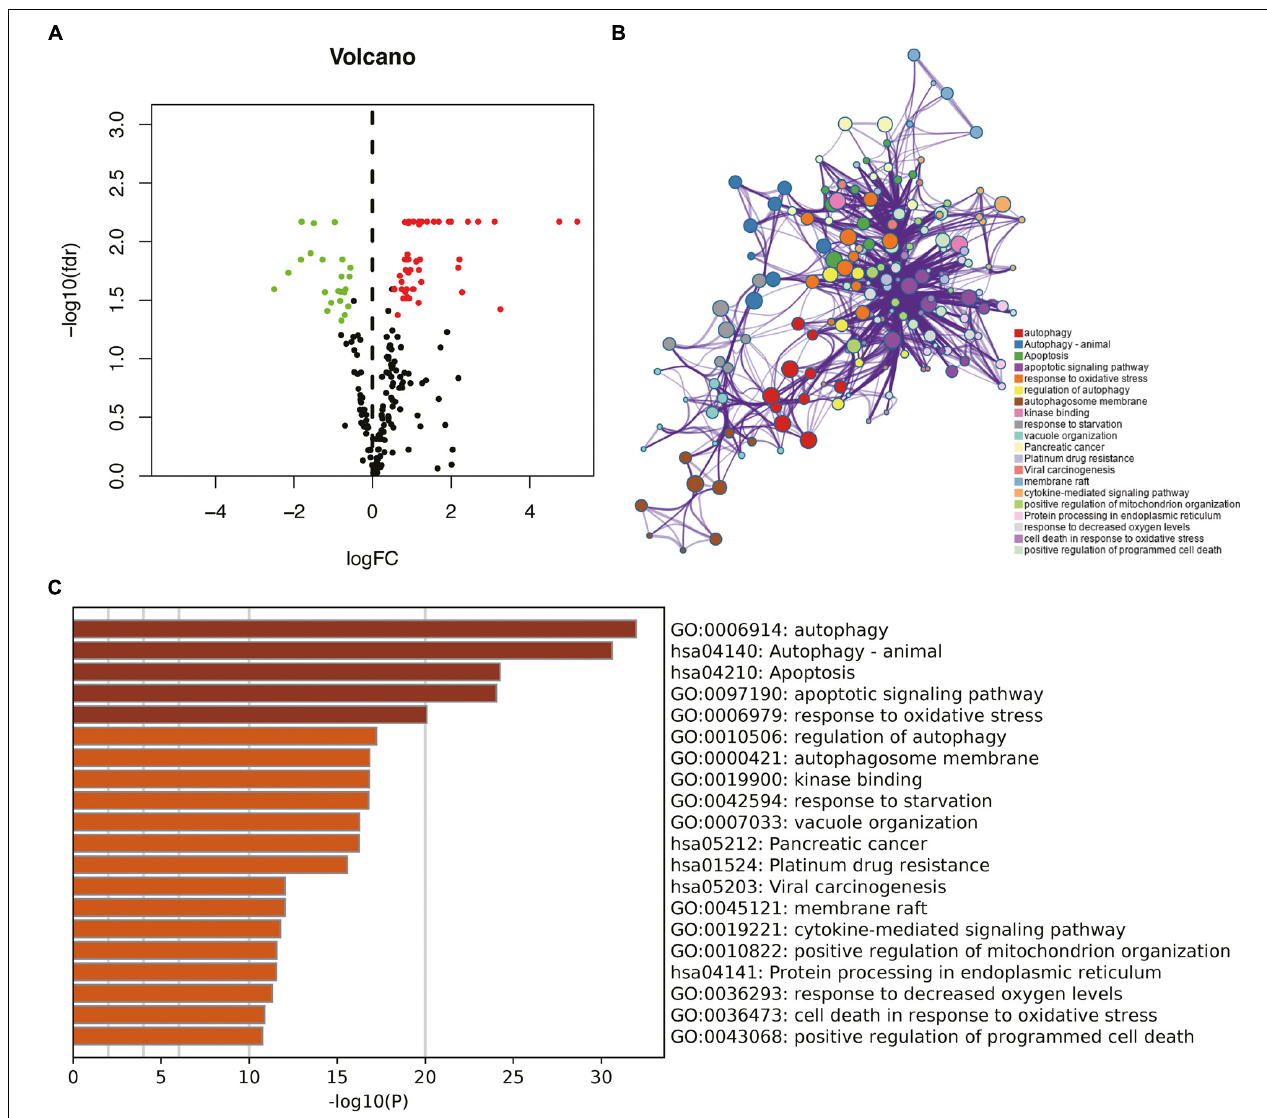
FIGURE 1 | Identification of differentially expressed autophagy-related genes (DEARGs) in glioma and biological function analysis. (A) Volcano plot of DEARGs in tumor and normal samples of The Cancer Genome Atlas (TCGA) dataset; the green dots represent down-regulated genes, and red dots represent up-regulated genes. (B) The functional enrichment map of pathways. Each node indicates an enriched term and is colored by its cluster ID. (C) Enriched pathways of the genes positively correlated with